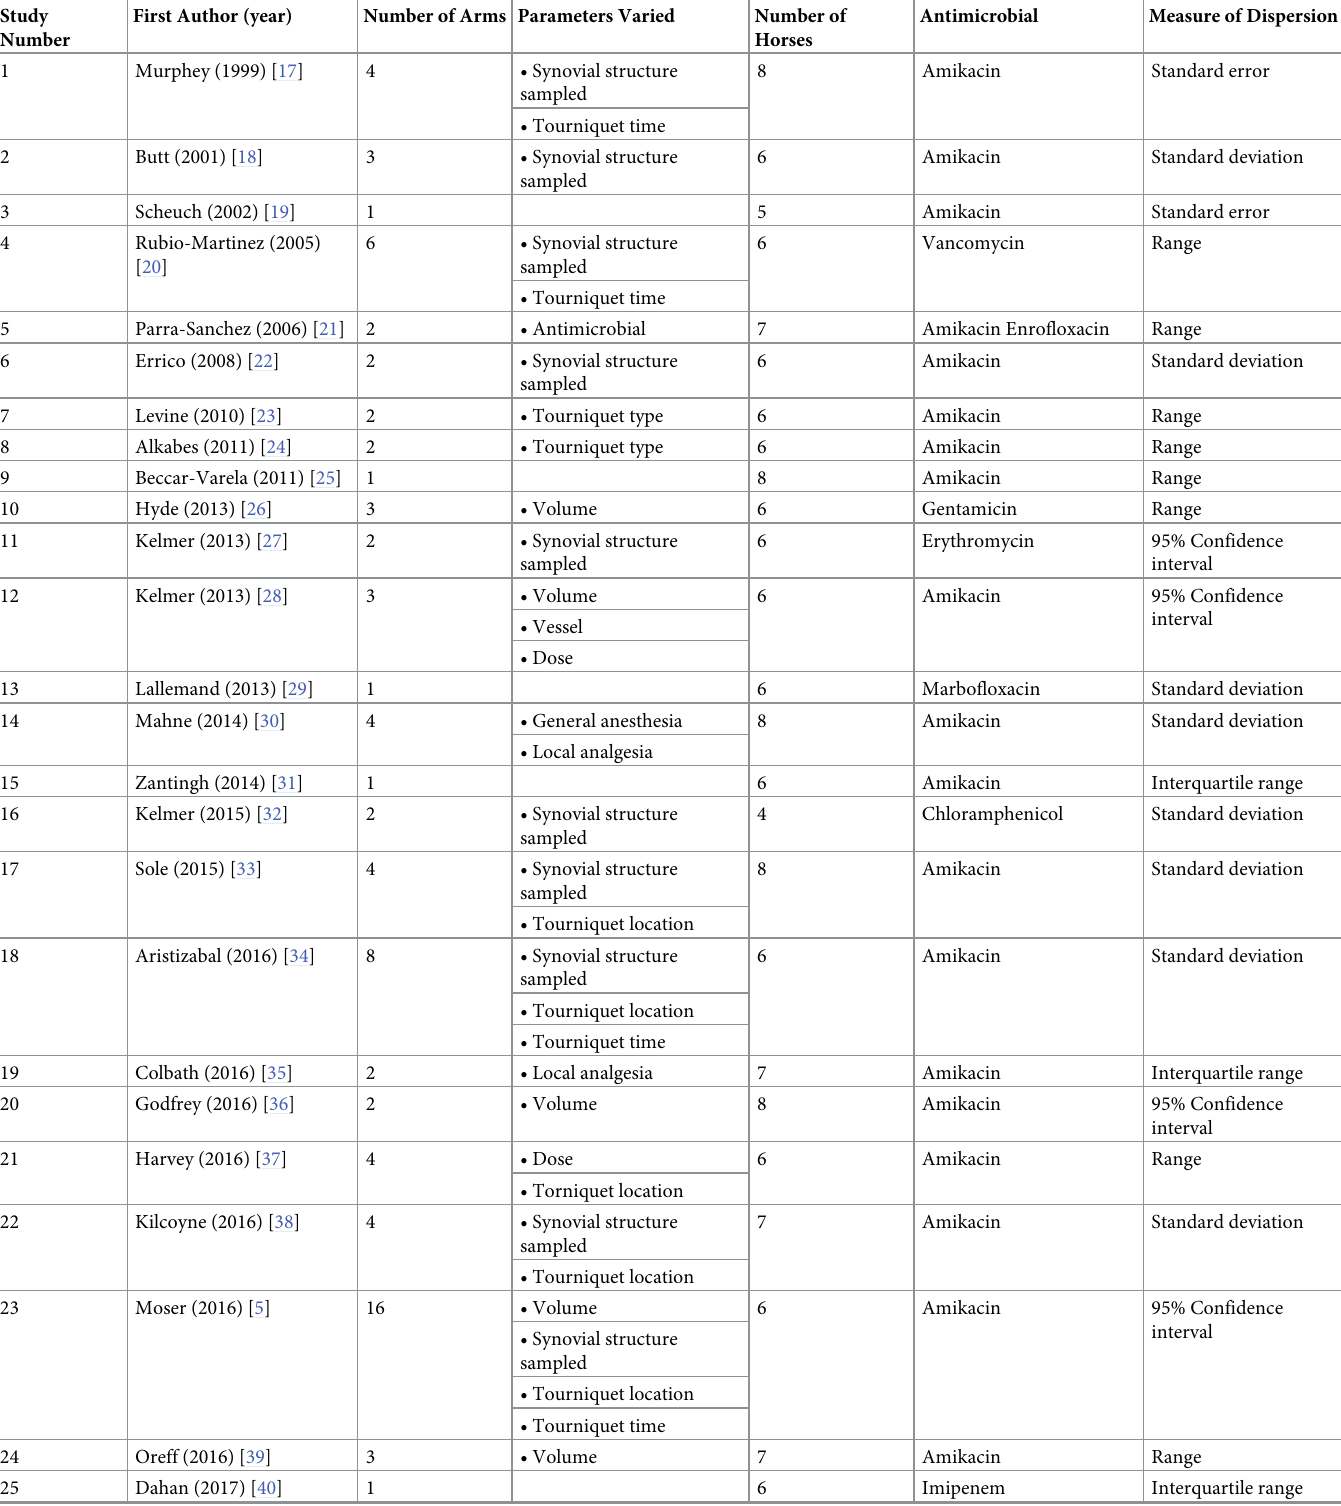
Table 1. Study characteristics for included